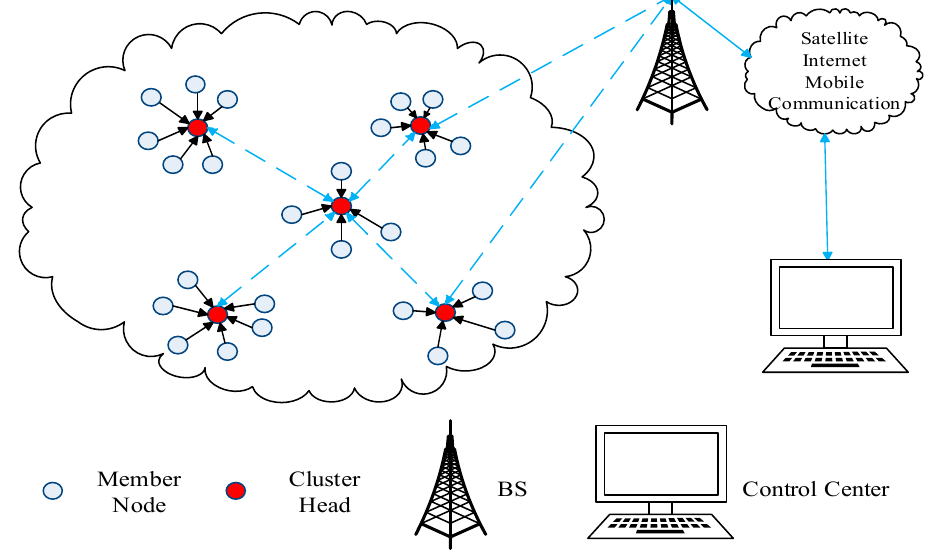
Figure 1. A typical wireless sensor network (WSN) logical hierarchy diagram. BS: base station.